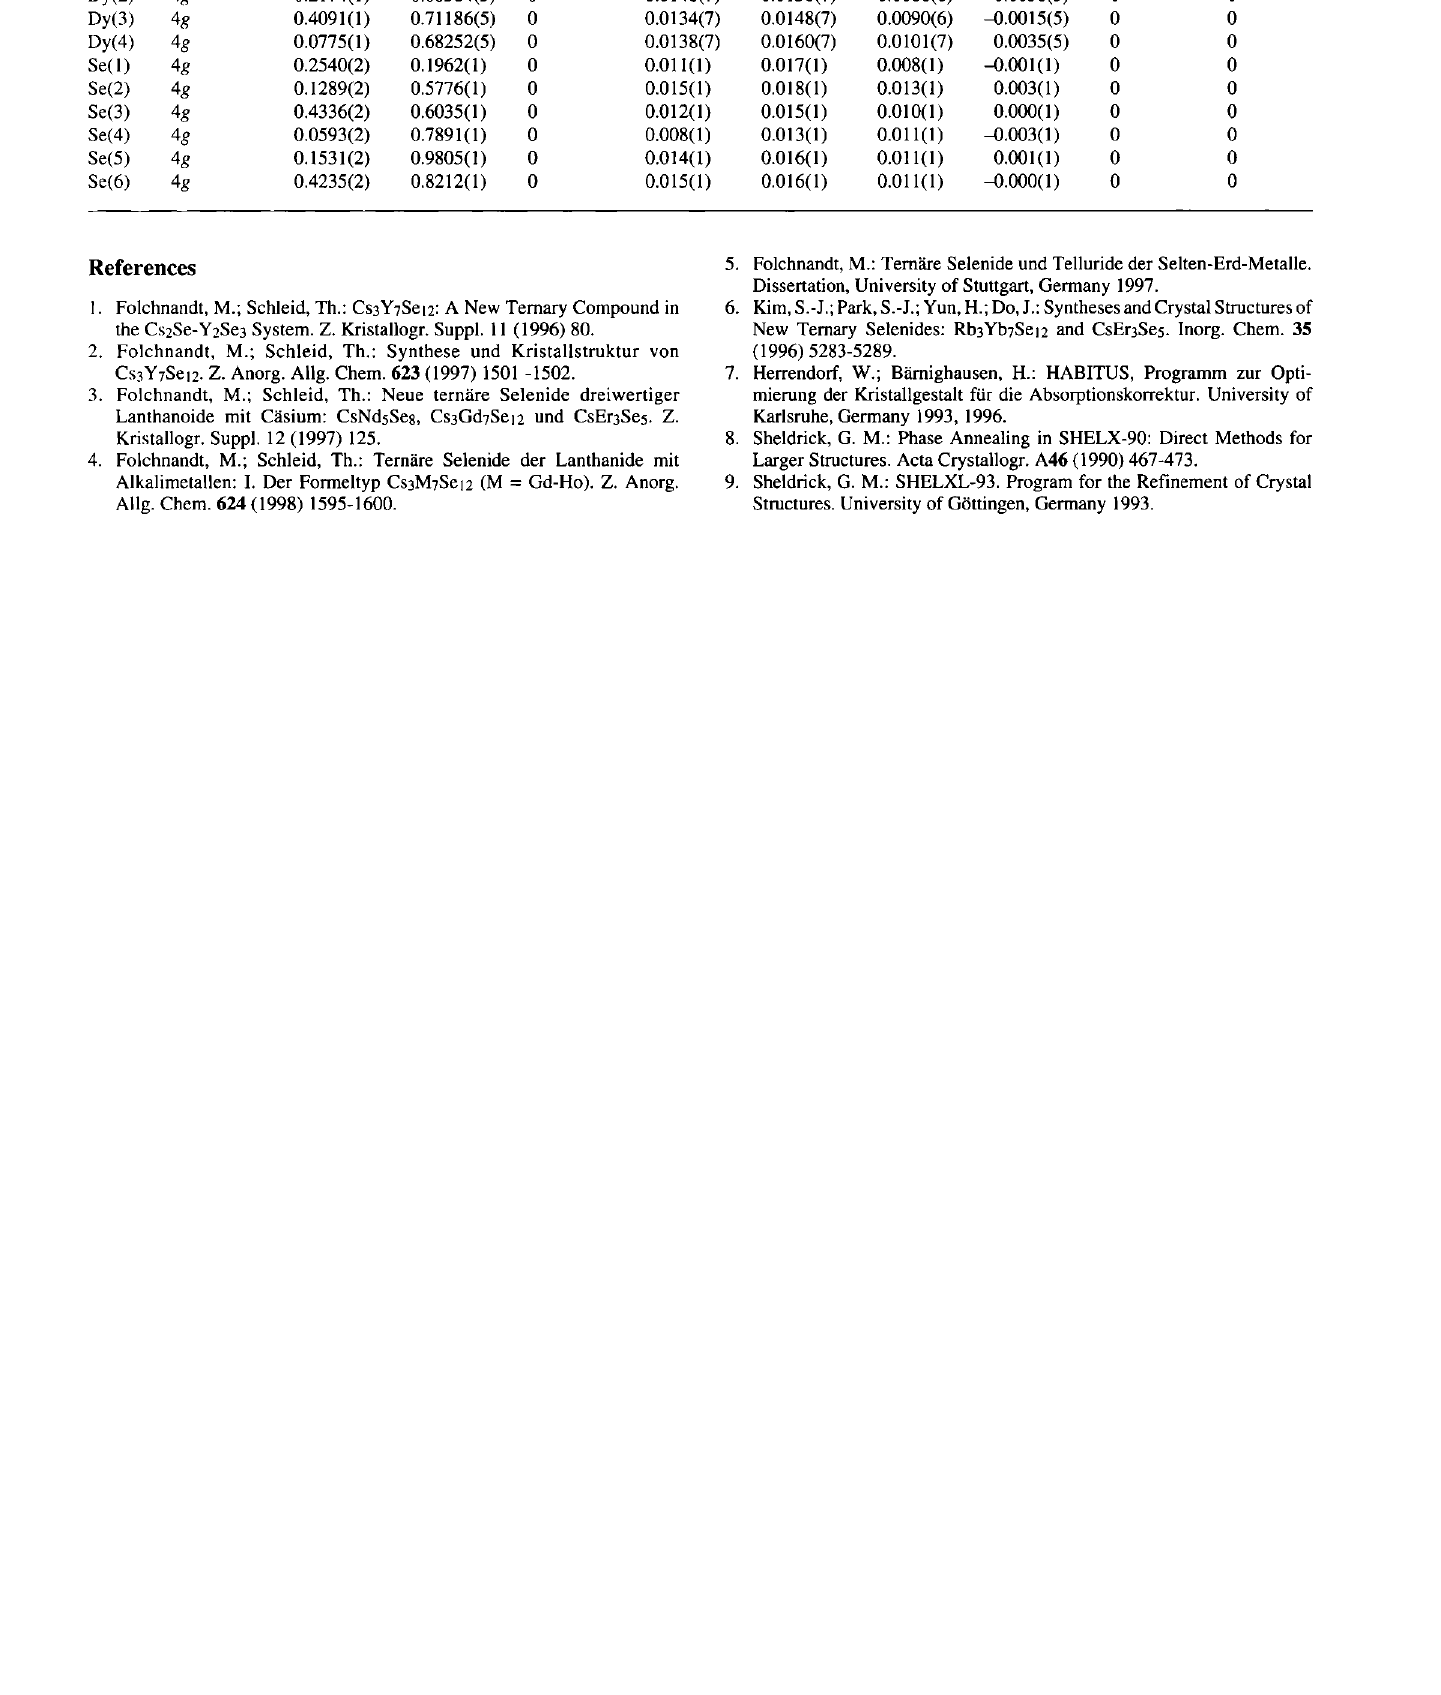
Table 2. Atomic coordinates and displacement parameters (in Ä 2 ). Atom Site